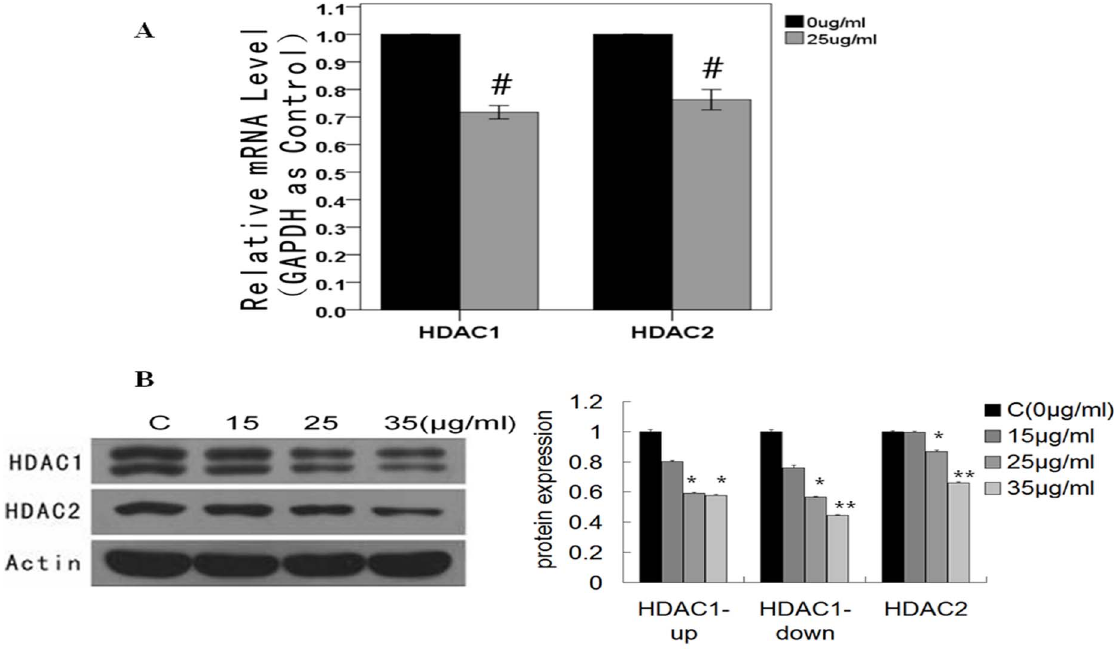
Figure 3. Effects of wogonin on HDAC1 and HDAC2 in A549. (A) Relative mRNA levels of HDAC1 and HDAC2 were detected using real-time PCR with GAPDH as an internal control. Results are expressed as the mean 6 SEM of five independent experiments. # P , 0.01 vs control group. (B) Protein levels of HDAC1 and HDAC2 assayed by western blot. In these experiments, cells were exposed to wogonin 0, 15, 25 and 35 m g/mL for 48 h. * P , 0.05 vs control group, ** P , 0.01 vs control group.